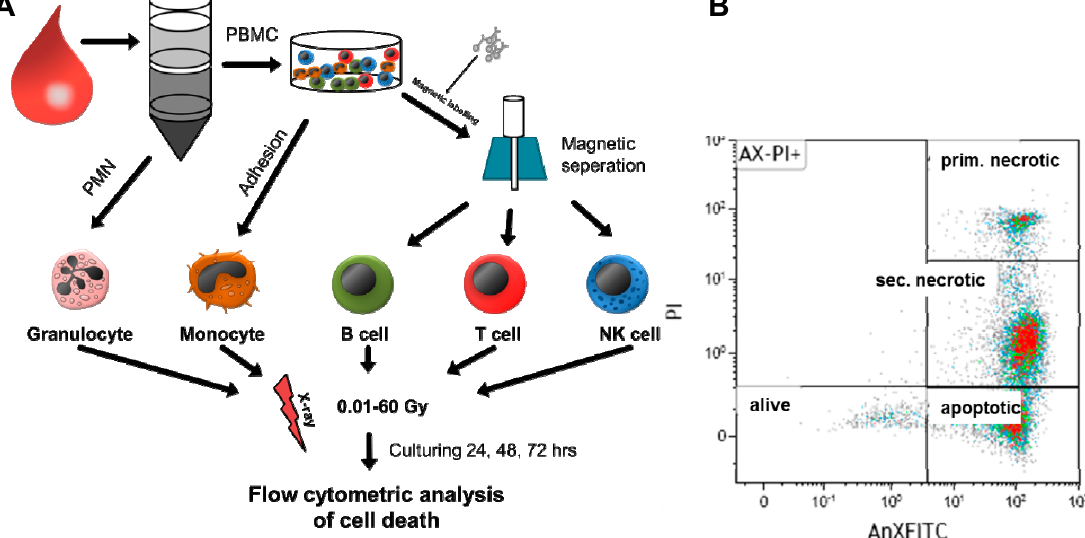
Figure 1. Scheme of experimental design showing the procedure of cell isolation and irradiation as well as cell death analysis by flow cytometry. ( A ) From whole-blood samples, various human immune cells were isolated by Ficoll separation followed by magnetic labeling or adherence techniques. Afterwards, cells were irradiated with X-rays (0.01–60 Gy). After 24, 48, or 72 h, cells were harvested and stained with AnnexinV (fluorescein isothiocyanate (FITC)-labeled) and propidium iodide (PI). ( B ) Then, samples were analyzed by flow cytometry for identification of viable (alive), apoptotic, primary (prim.) necrotic, and secondary (sec.) necrotic cells. The colors represent the amount of cells: high cell density: red; lower cell density: green.